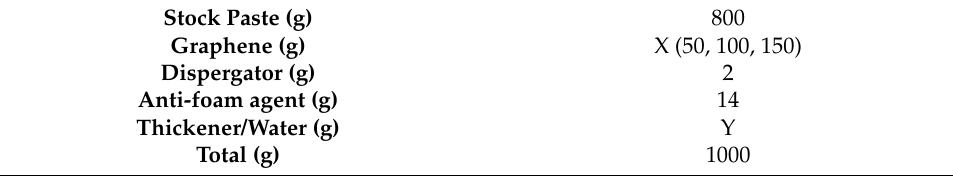
Table 4. Recipe of coating